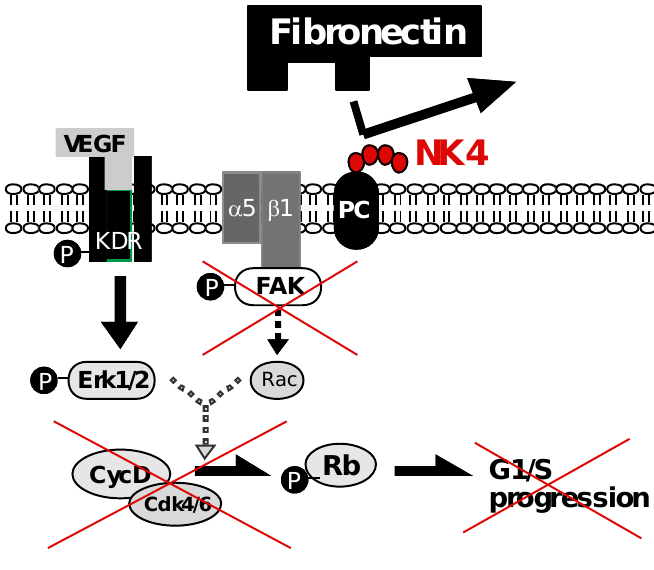
Figure 3. Involvement of perlecan (PC) in NK4-mediated growth arrest of endothelial cells. Cell surface PC is required for the binding of fibronectin and α5β1-integrin, leading to FAK phosphorylation and crosstalk of VEGF–VEGF receptor (KDR) signaling. NK4 binds to PC, and then the binding of fibronectin to integrin is impaired. As a result, VEGF fails to elicit G1/S progression of endothelial cells in the presence of NK4